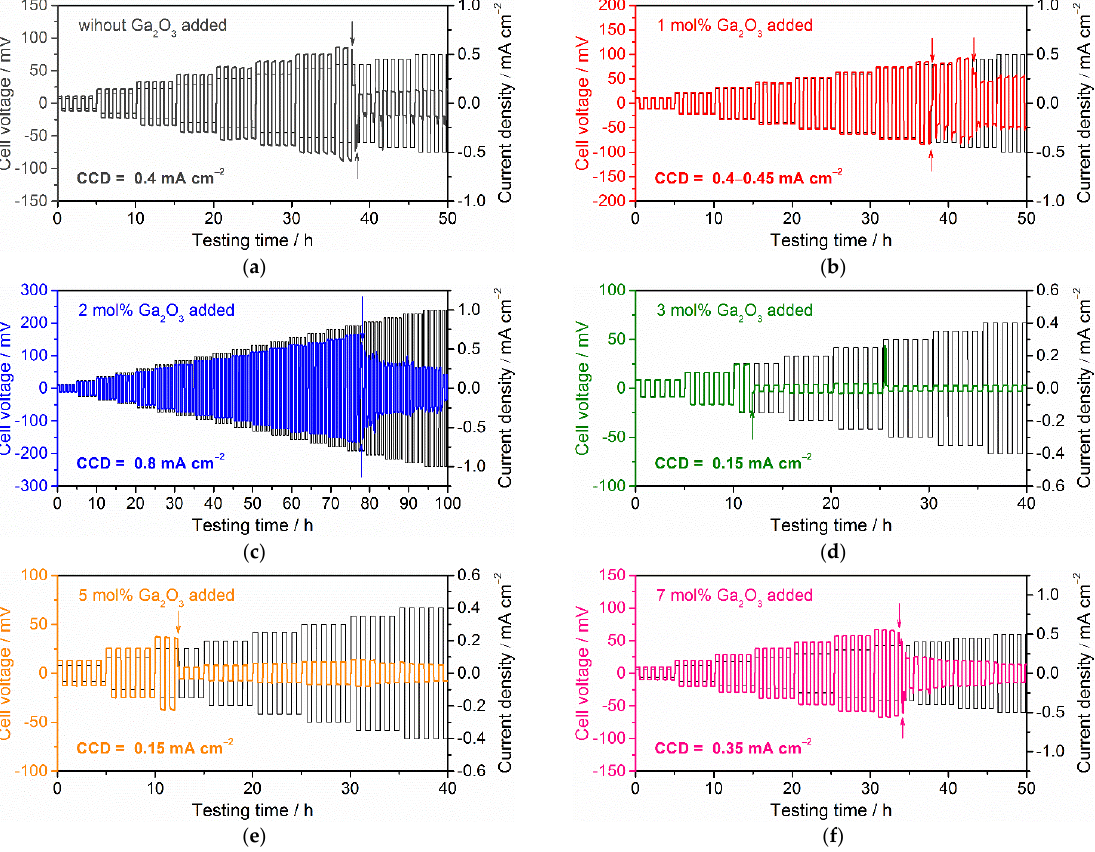
Figure 7. Cell voltage changes during galvanostatic cycling test at 25 °C for Li symmetric cell with Ta-doped LLZO: ( a ) without Ga 2 O 3 addition, ( b ) 1 mol % Ga 2 O 3 addition, ( c ) 2 mol % Ga 2 O 3 addition, in each graph represent the sudden voltage drops caused by possible Li dendrite growth into a solid